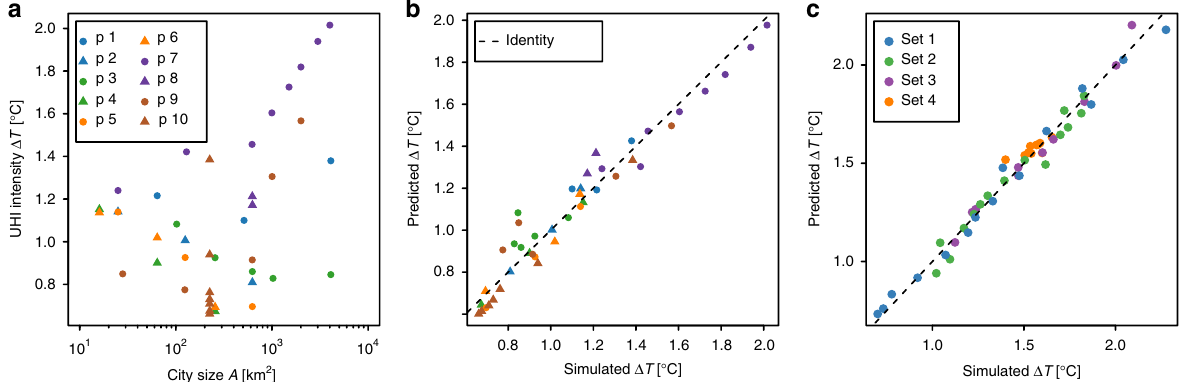
Fig. 3 UHI intensity as a function of city size and form attributes. a The UHI intensity is plotted against city size of corresponding spatial patterns (Supplementary Fig. 3, Table 1). b The UHI intensity predicted by Eq. (2) is plotted against simulated UHI intensity. c For the realistic urban clusters (Supplementary Fig. 1), the UHI intensity predicted by Eq. (3) is plotted against simulated UHI (42 simulations), we obtain b 1 = − 0.19 K, b 2 = 0.04 K km 3/2 , b 3 = 1.60 K, and R 2 = 0.95. The performance is visualised in Fig. 3b, where predicted and simulated UHI intensities are plotted against each other. In the Supplementary Fig. 4, we show how we found the value of the exponent δ based on the simulations of pattern 10 (Supplementary Fig. 3), i.e., a square of constant N but with varying space between the urban pixels. the urban sites contains the information necessary to capture the UHI intensity of basically any urban shape.